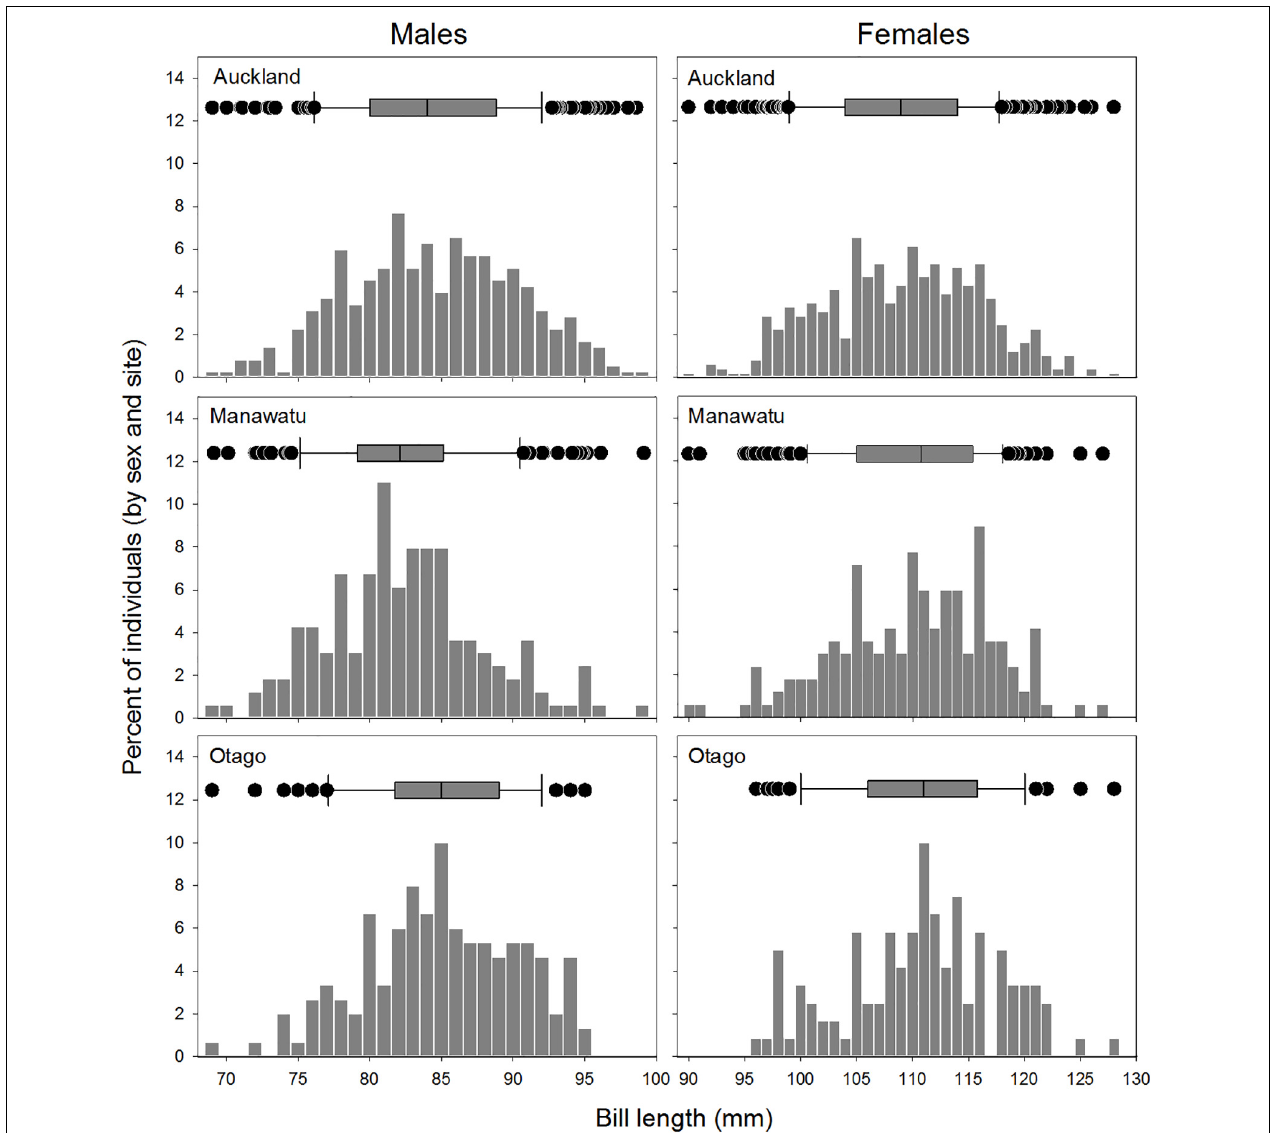
FIGURE 2 | Size-distribution of bar-tailed godwits at the Auckland, Manawatu, and Otago sites, plotted for females and males separately. Samples sizes are (male/female): Auckland 350/487; Manawatu 163/168; Southland 150/120. Boxplots across the tops of each plot summarize the distribution of values in each group (boxes show the median and 25th to 75th percentiles, whiskers the 5th and 95th percentiles, and points show outliers).